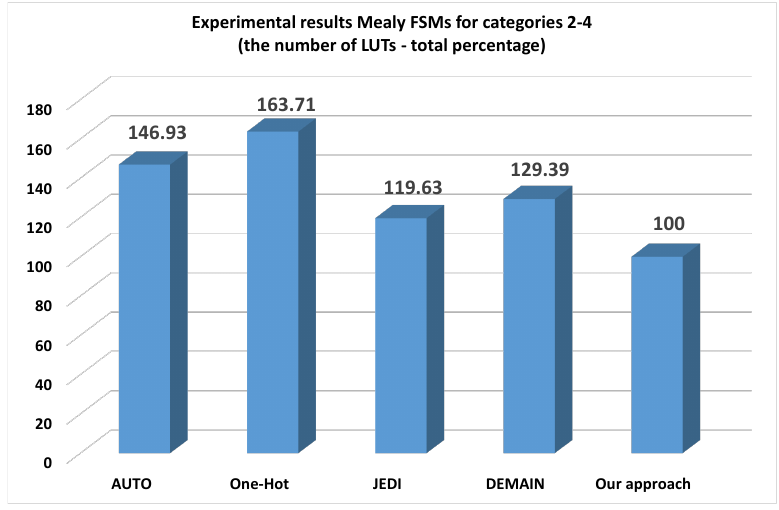
Figure 11. Experimental results for categories 2–4 (the number of LUTs—total